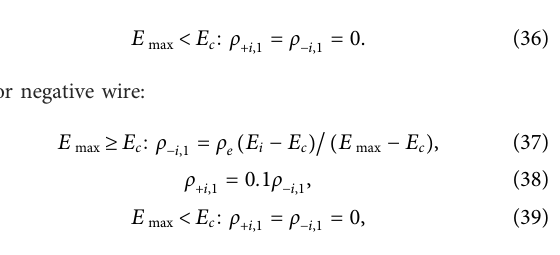
FIGURE 9 Changes in the maximum ion current density on the ground under ± 800 kV power lines with different roughness coef fi